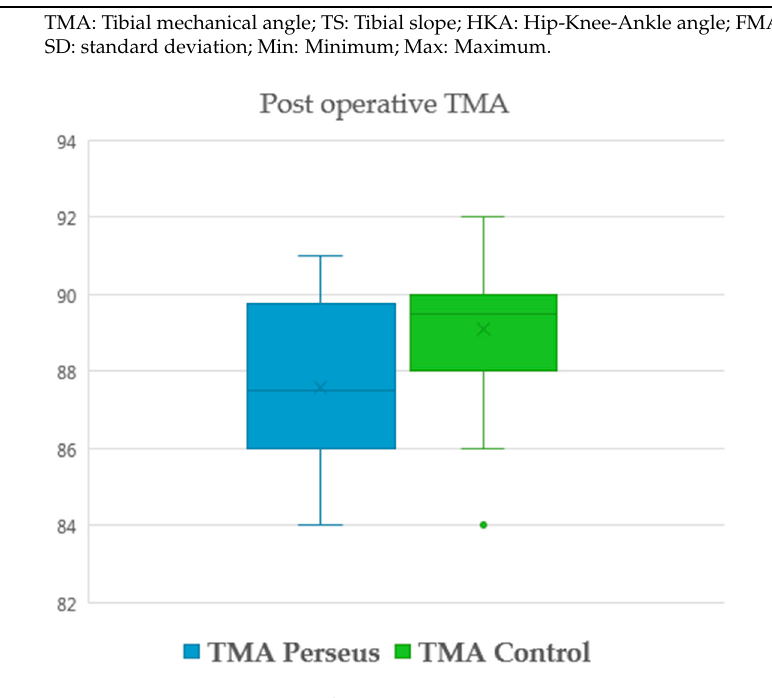
Figure 3. TMA comparison chart.